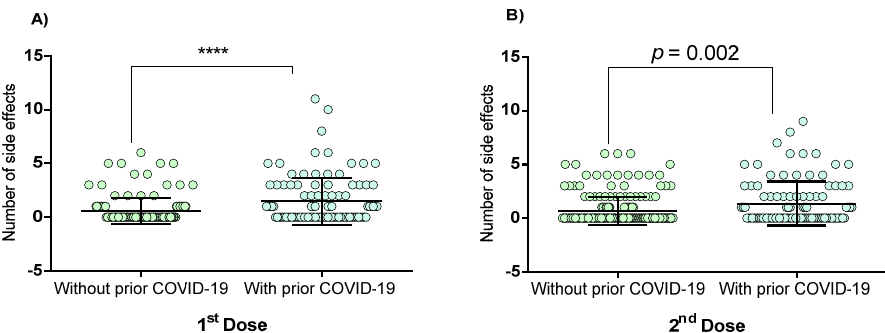
Figure 1. Side effects to Pfizer–BioNTech vaccine in patients with and without prior COVID-19. ( A ) Side effects to a first dose; ( B ) Side effects to the second dose. Data were calculated using the Mann–Whitney U-test. Values are provided as medians and interquartile ranges. **** p < 0.0001.